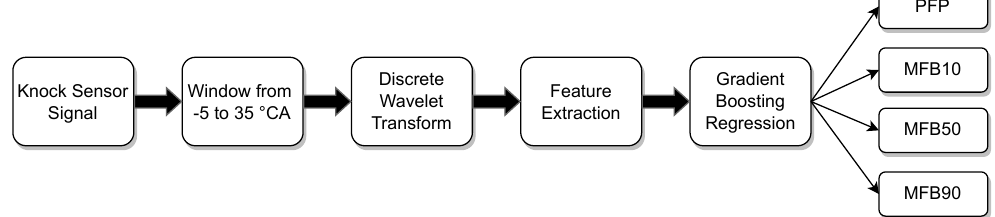
Figure 6. Overview of introduced method including regression